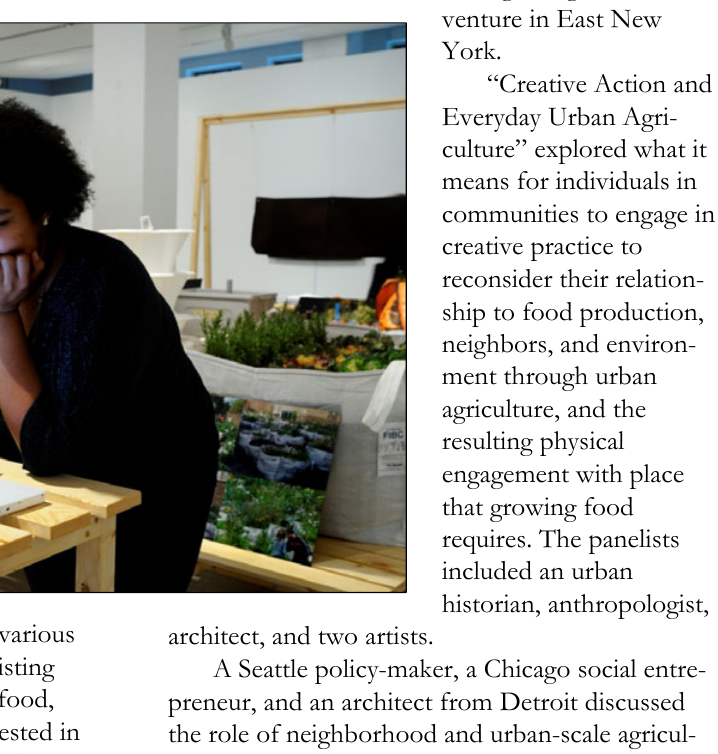
Figure 7. Examining Carrot City Cases